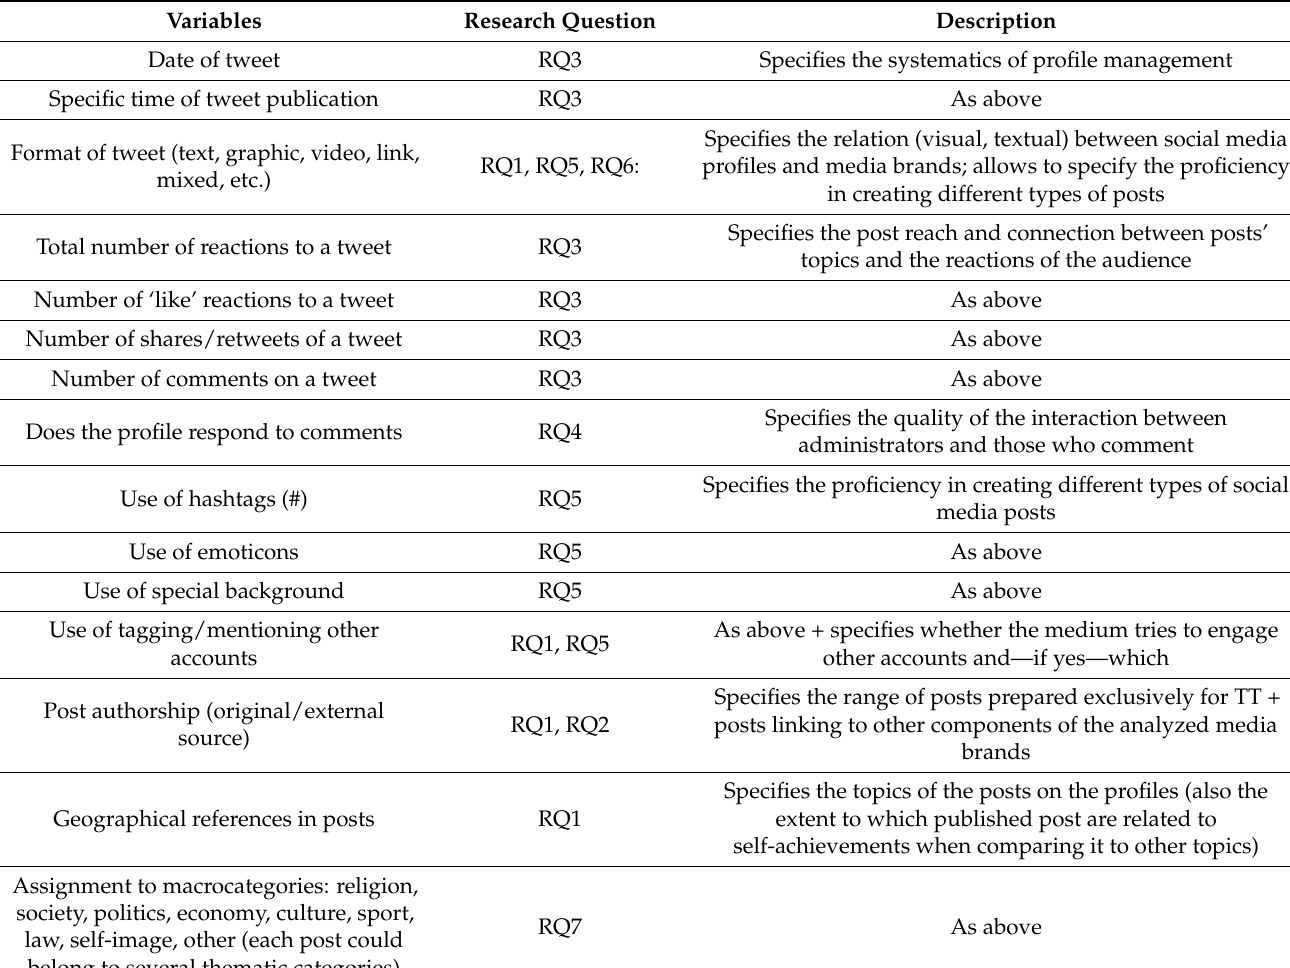
Table 2. Content coding schedule—adaptation for TT profile (Stage